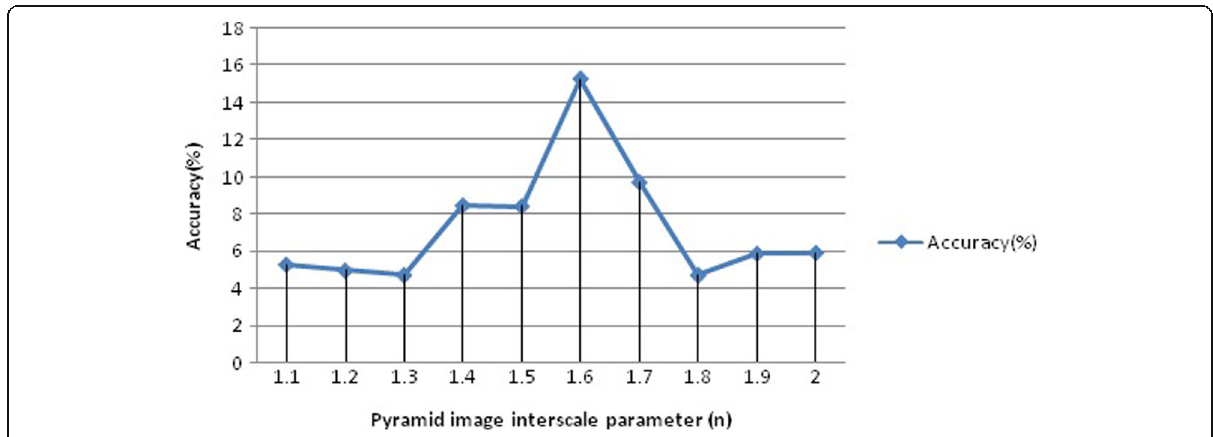
Fig. 20 Relationship between scale parameter variation and matching accuracy of pyramid